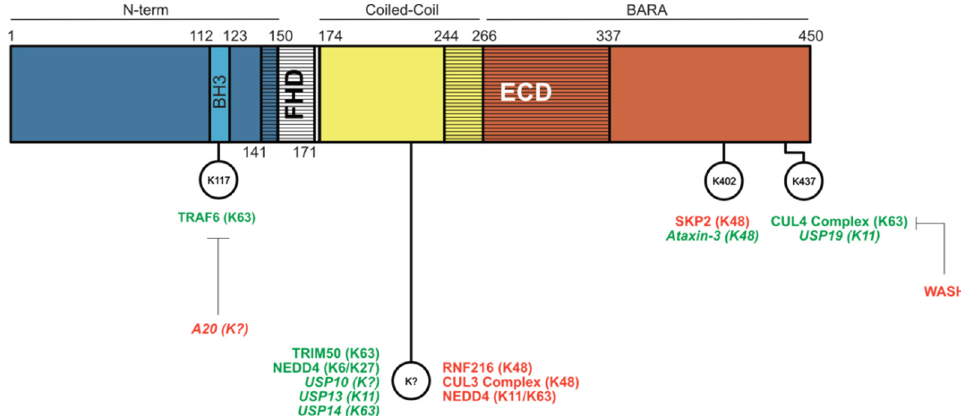
Figure 4. Ubiquitination events that regulate BECLIN1. E3 ligases that stabilise BECLIN1 protein levels and/or promote autophagy are indicated in green, whereas those with degradative effects on BECLIN1 that downregulate autophagy are indicated in red (note: WASH is the only non-E3 ligase indicated here). DUBs are italicised and also follow the green and red colour code to indicate their pro- or anti-autophagic effects.